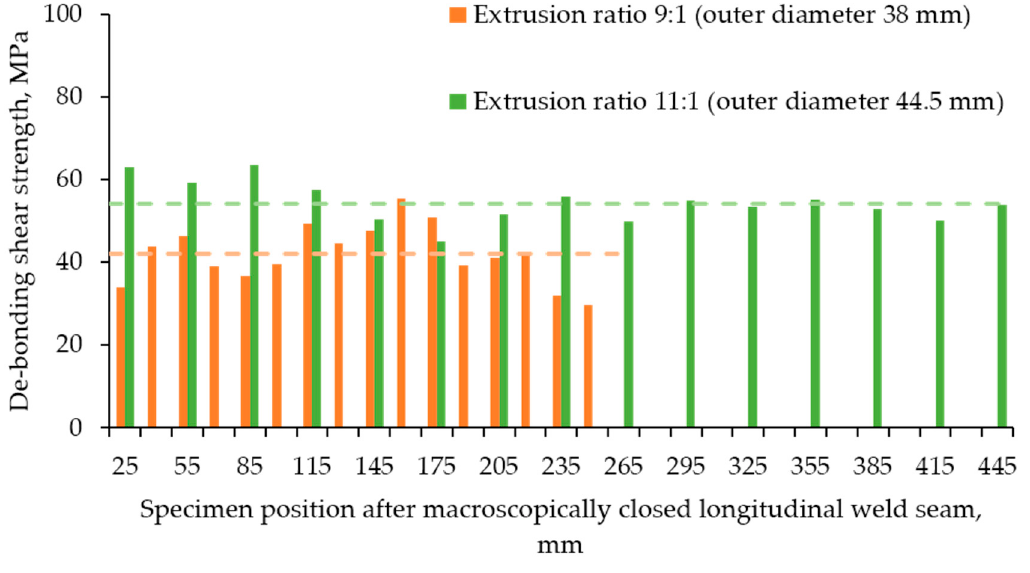
Figure 10. De-bonding shear strength for compound profiles produced via LACE with an extrusion ratio of 9:1 or 11:1, respectively. The respective mean values are indicated by dashed lines, which were determined over the entire length of the profile with macroscopically intact longitudinal weld seams.